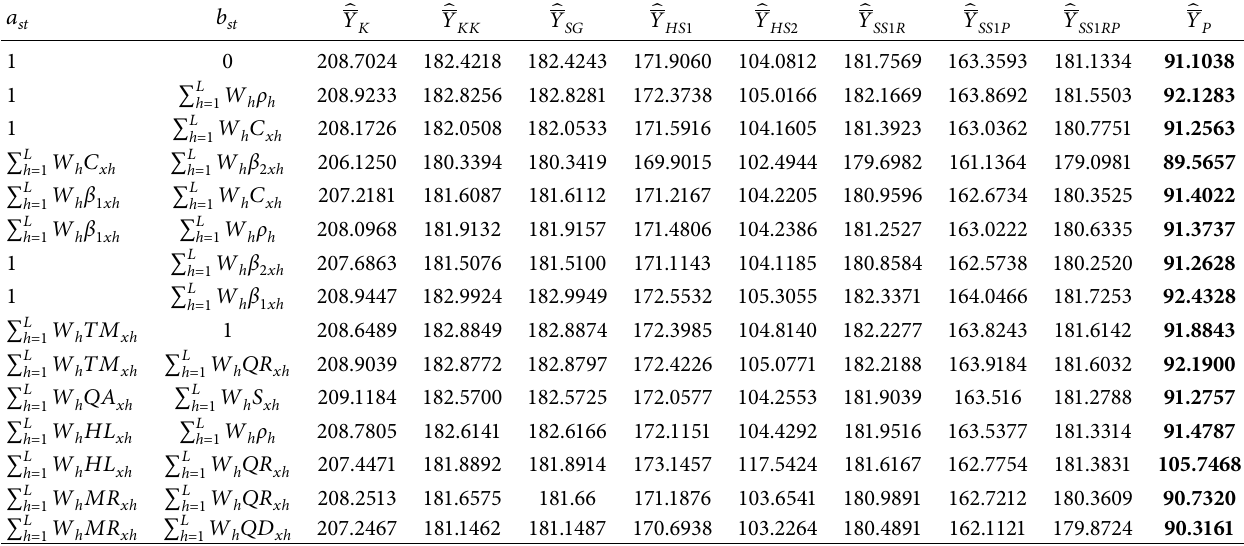
Table 6: Minimum MSEs of different estimators based on the simulation study ( n � 180).